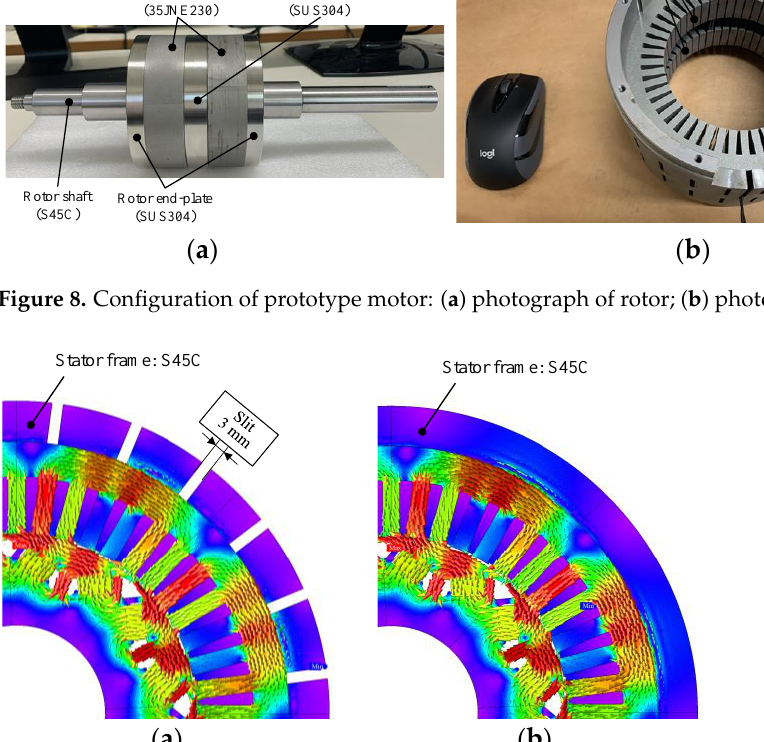
( b ) without slit. ( b ) without slit.